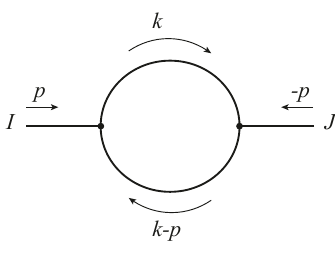
Figure 5 . The one-loop graph from cubic